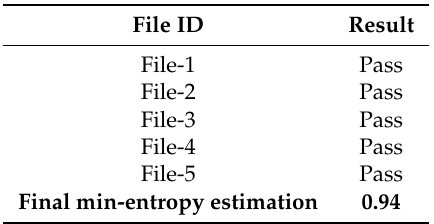
Table 2. Restart tests (NIST SP 800-90B